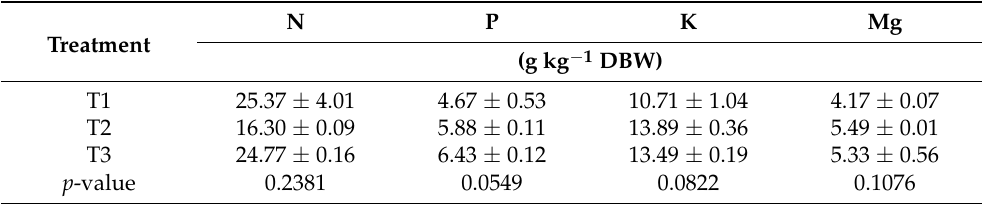
Table 5. Concentrations of N, P, K, and Mg in leaf tissues of lulo ( Solanum quitoense Lam.) seedlings grown in substrates containing different percentages ( v / v ) of peatmoss and compost under green- house